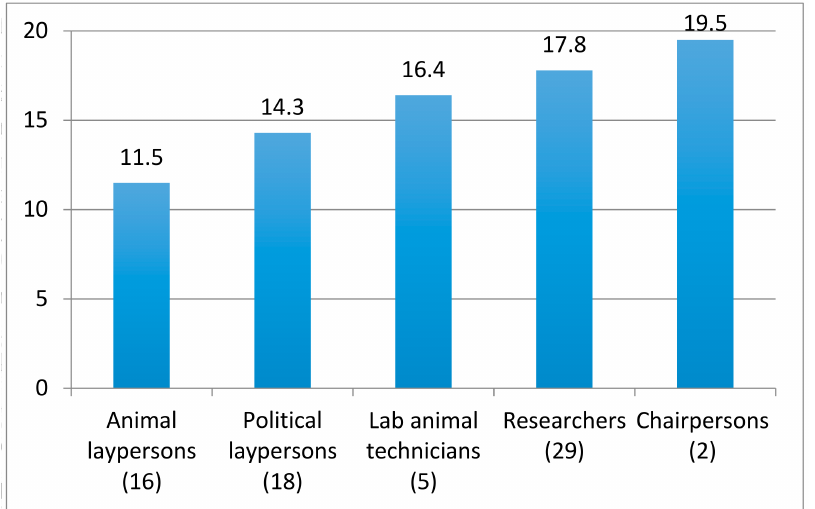
Figure 2. Animal Ethics Committee (AEC) members’ experience of plenary meetings. Sum